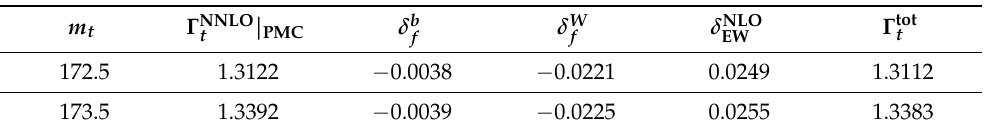
Table 2. PMC top-quark decay widths Γ NNLO quark mass δ b , the finite W -boson width δ W f presented, whose magnitudes are taken from Ref.